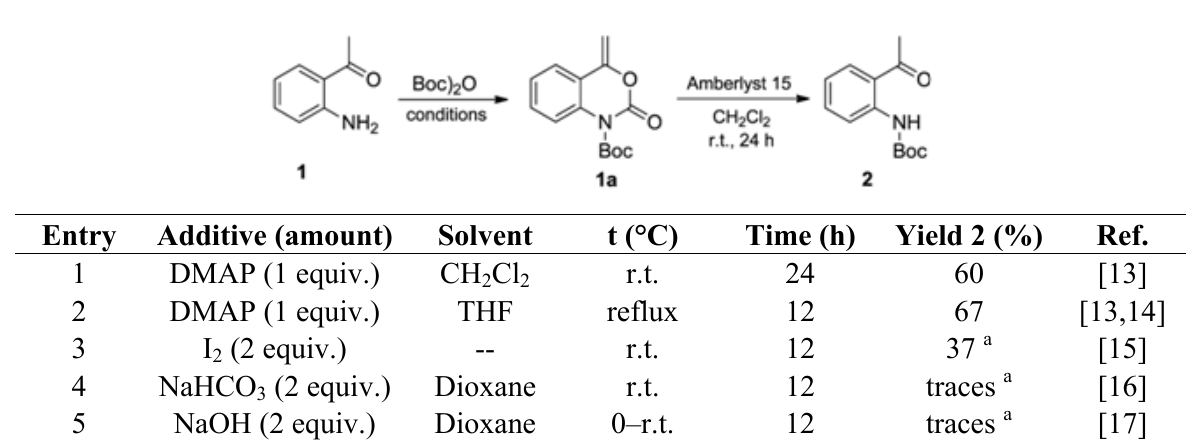
Table 1. Synthesis of tert -butyl (2-acetylphenyl)carbamate ( 2